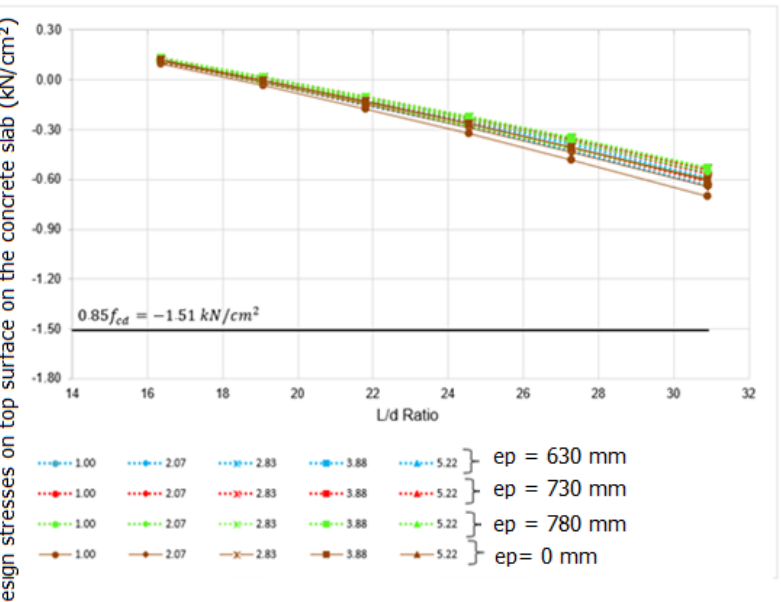
Figure 17. Graph of stresses on the top surface of the concrete